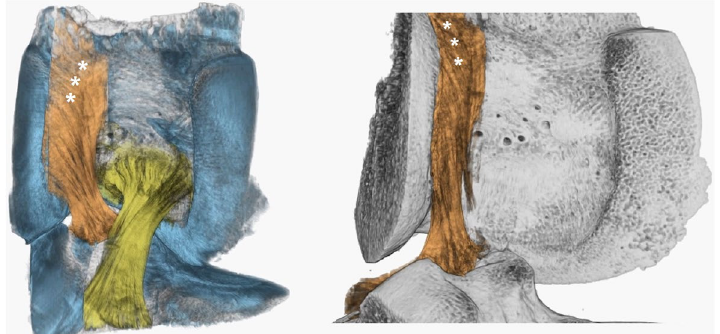
Fig. 3 3D- CT of the intercondylar groove. The ACL (orange) is composed of a multitude of fibers. The stars indicate the direct fibers, directed in the “Over the top”